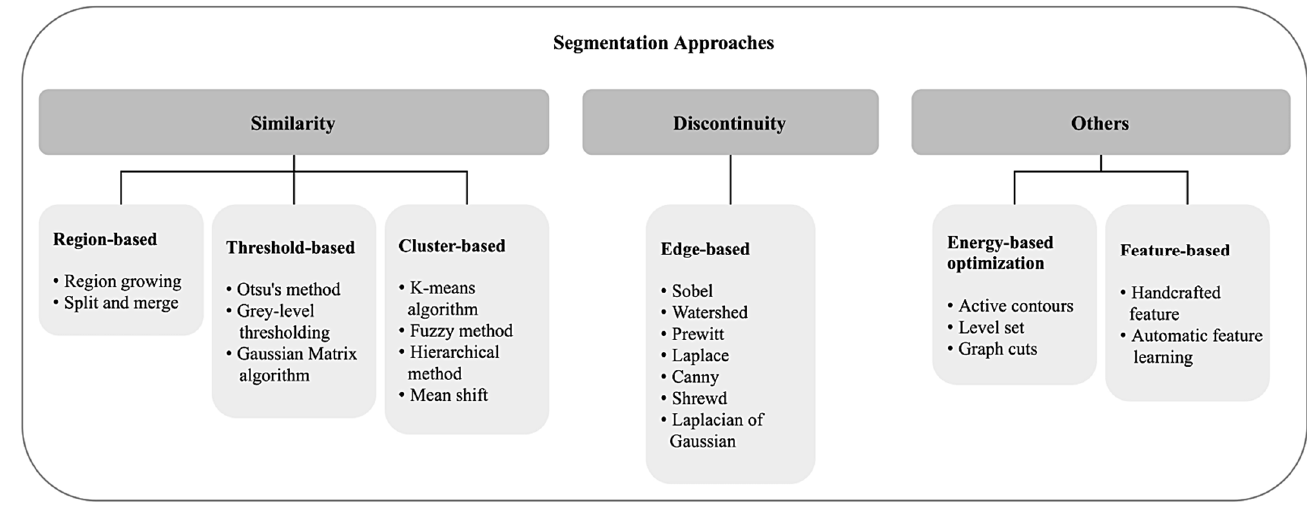
Table 4. Summary of segmentation approaches along with their definition, advantages, and limitations.